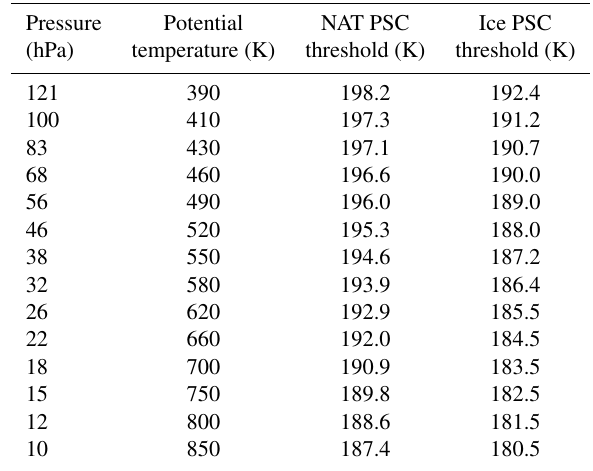
Table A2. Pressure levels, approximately corresponding potential temperature levels, and the NAT and ice PSC thresholds calculated from Table A1. Pressure values are rounded to the nearest integer; NAT and ice PSC thresholds are rounded to the nearest tenth of a